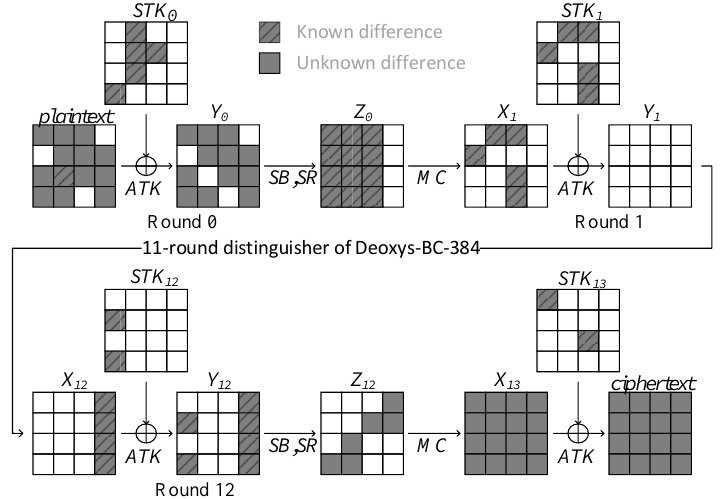
Figure 4: Key recovery attack against 13-round Deoxys-BC-384 with data complexity below